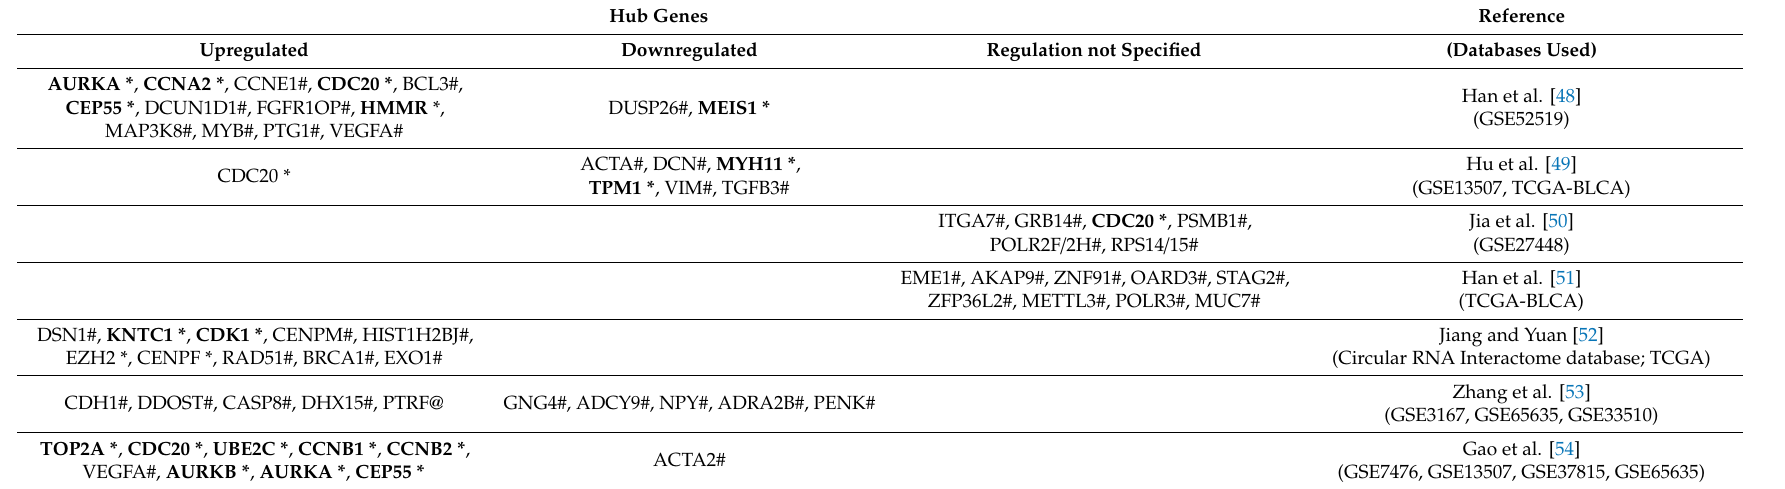
Table 3. Hub genes predicted and studied in previous bioinformatics analyses of